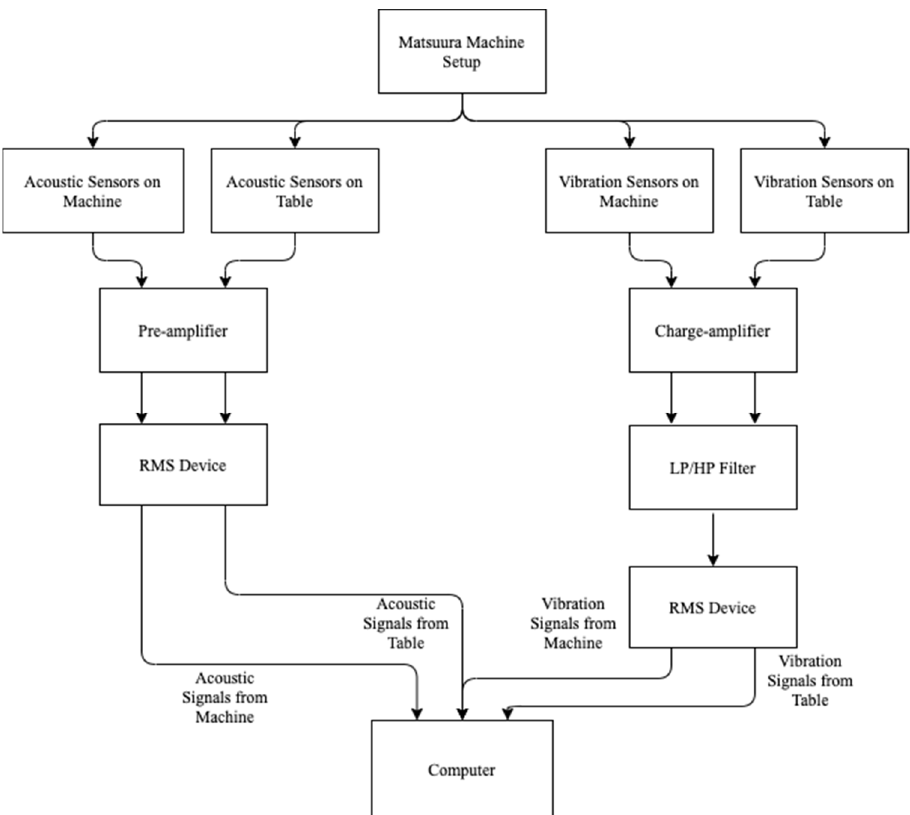
Figure 3. Milling operation setup, adapted from [79]. The experimental data from [79,80] consisted of 16 cases with varying DOC, feed and materials. These 16 cases were used as experimental conditions and run multiple